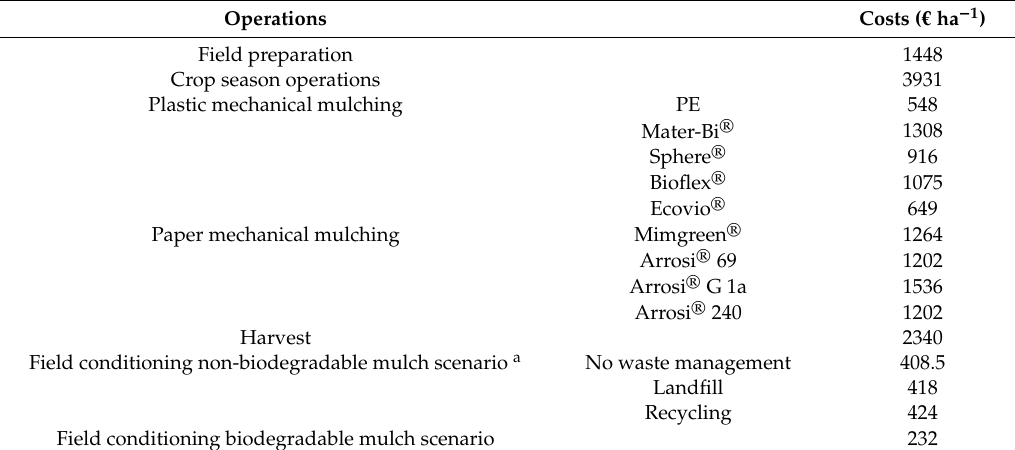
Table 4. Costs ( € ha − 1 ) for fresh pepper crop